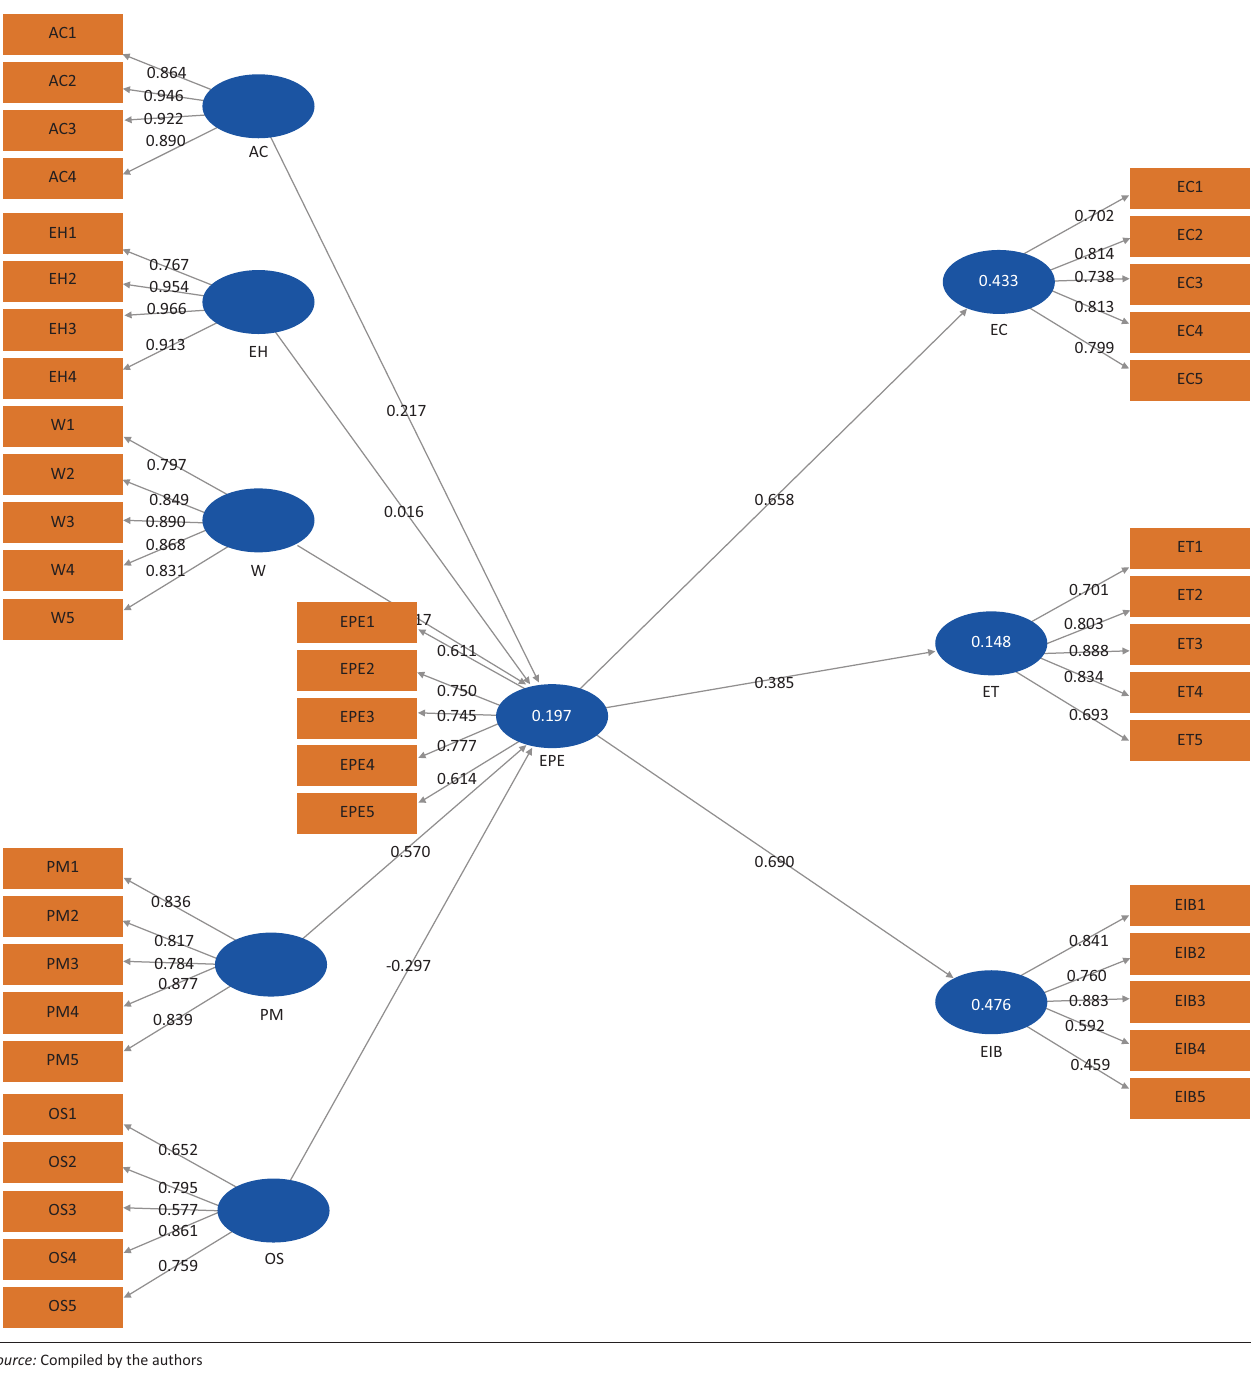
FIGURE 2: Measurement and structural model